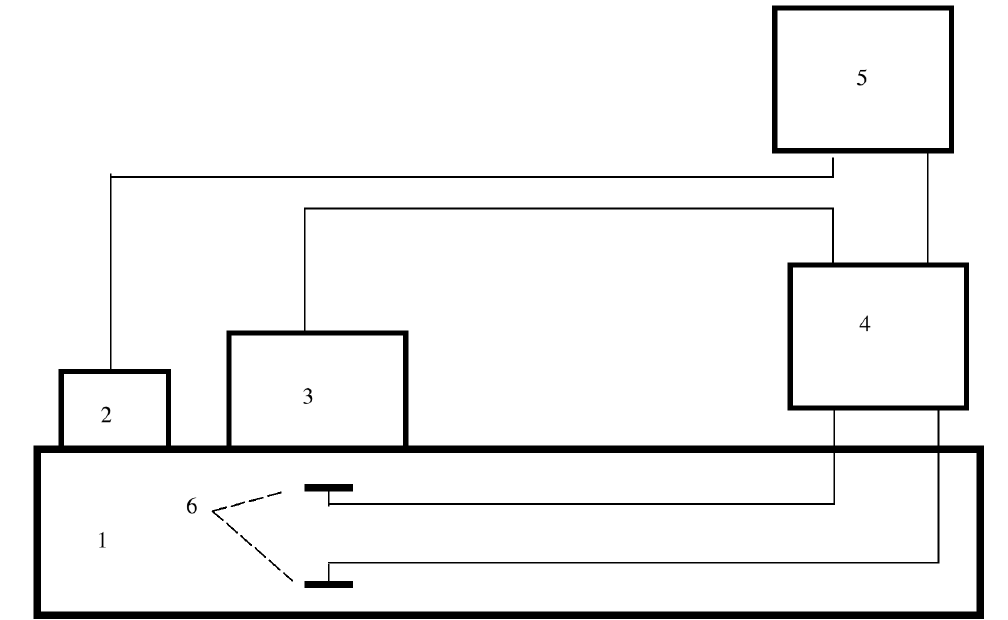
Fig. 4. The scheme of the self-oscillator (MSO) of the second type ( E - S ): 1 – sample (box with sand); 2 – measuring piezoelectric transducer; 3 – piezoelectric transducer-receiver; 4 – electronic unit; 5 – recording de- vice; 6 – emitting